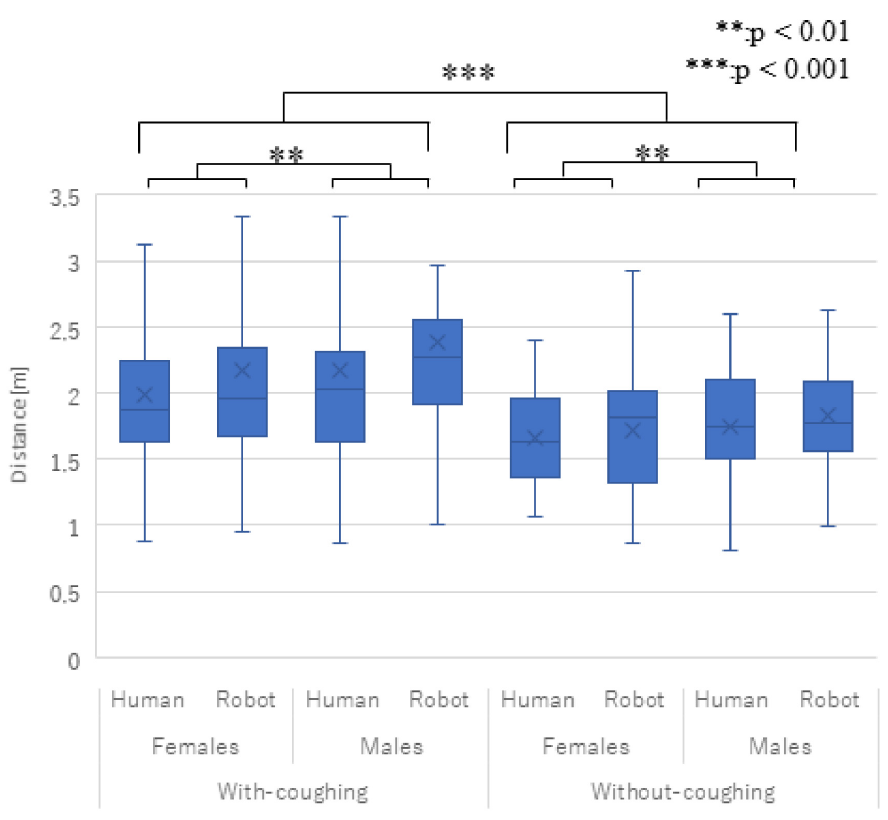
Fig 4. Average and S.E. of distance from virtual agents. The gender and coughing factors showed significant main effects. p = 0.668, partial η 2 = 0.006), the two-way interaction effects between the type and coughing fac- tors ( F (1,29) = 2.609, p = 0.117, partial η 2 = 0.083), the two-way interaction effects between the gender and coughing factors ( F (1,29) = 1.531, p = 0.226, partial η 2 = 0.050), or in the three-way interaction effects among the factors ( F (1,29) = 0.013, p = 0.909, partial η 2 = 0.001).